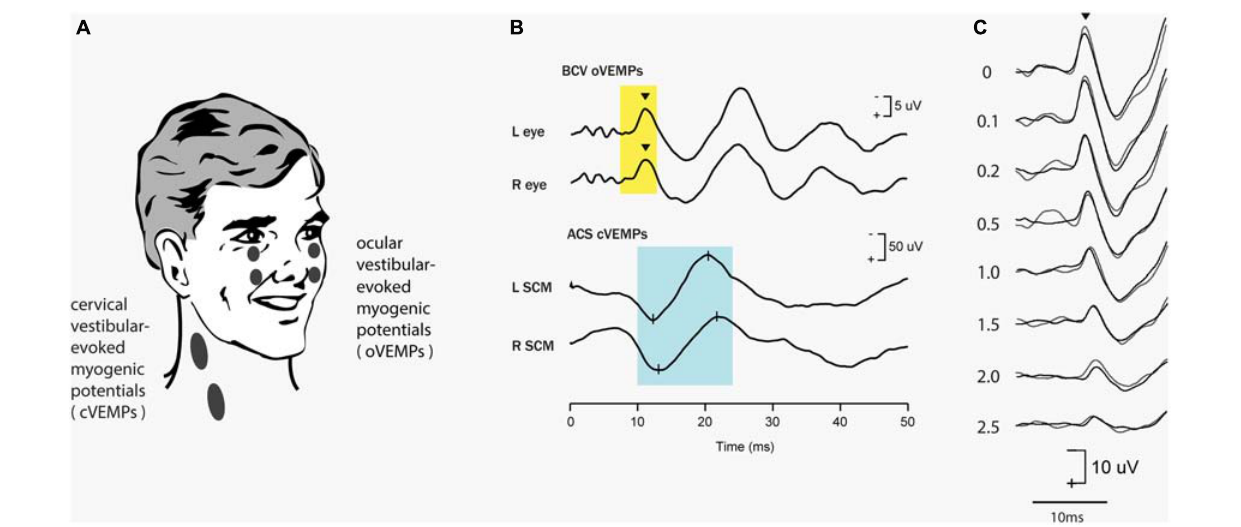
FIGURE 1 | Vestibular evoked myogenic potentials (VEMPs). There are a host of VEMPs since vestibular input projects indirectly to many muscle groups. The two VEMPs which have received the most attention are cervical VEMPs (cVEMPs) and ocular VEMPs (oVEMPs). cVEMPs are recorded by surface EMG electrodes over the tensed sternocleidomastoid muscles (SCM) (Colebatch and Halmagyi, 1992; Colebatch et al., 1994; Adams et al., 2010). The cVEMP consists of a short-latency (13 ms from onset to peak) positive (i.e., inhibitory) EMG potential in response to high-intensity ACS or BCV (Halmagyi et al., 1995). Ocular VEMPs (oVEMPs) consist of a small (5–10 µ V) negative (i.e., excitatory) potentials recorded by surface electrodes on the skin beneath the eyes from the inferior oblique in response to BCV or ACS (Rosengren et al., 2005; Iwasaki et al., 2007). To record the oVEMP the subject must be looking up. (A) Electrode placement for oVEMPs and cVEMPs; the ground electrode (not shown) is typically on the chin or sternum. (B) Typical oVEMP and cVEMP records for a healthy subject in response to bilaterally equal amplitude stimuli: the magnitude of the n10 response is approximately equal beneath both eyes for the oVEMP, and, similarly, the magnitude of the p13-n23 response is approximately equal in both SCMs for the cVEMP. (C) For stimuli in the one subject, increasing the rise time of the 500 Hz stimulus reduces the amplitude of the oVEMP (Burgess et al., 2013). The number next to each record shows the rise time in milliseconds. Reproduced from